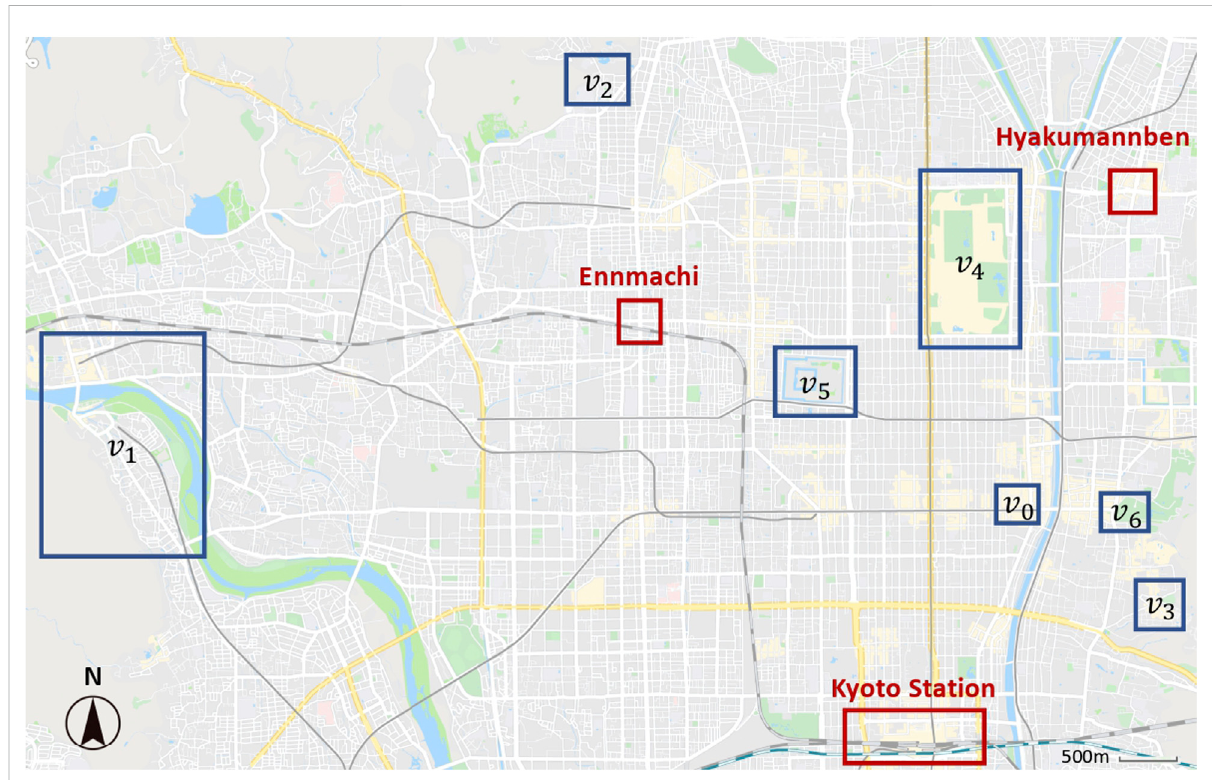
FIGURE 4 Map of Kyoto City showing the locations (nodes) used in the case study. The points surrounded by red boxes are the points handled in the temporal network mobility analysis, and the points surrounded by blue boxes are the points taken as nodes in the